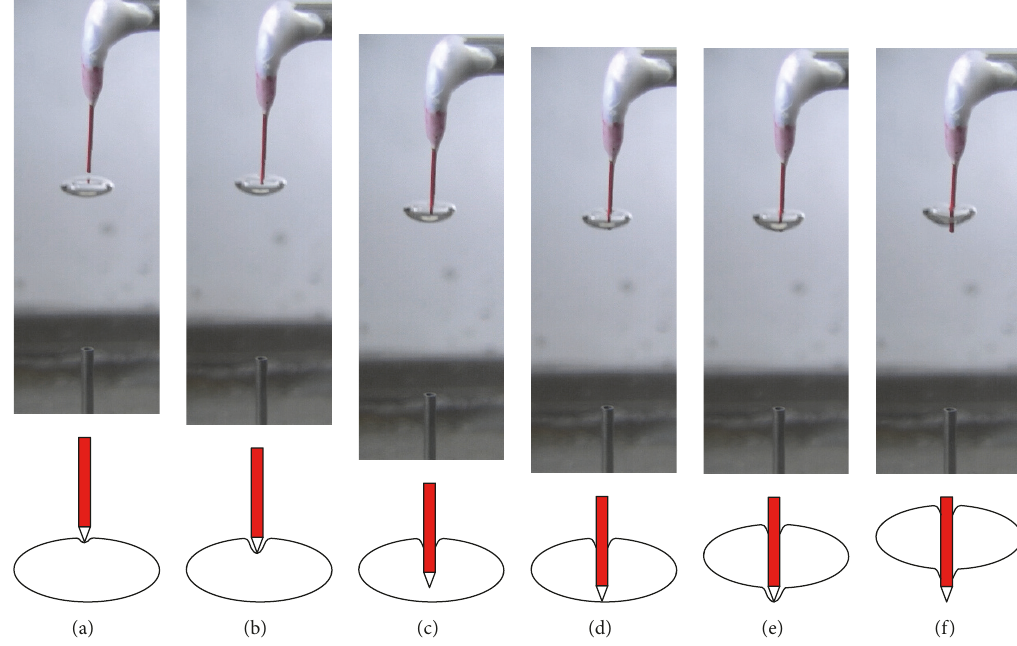
Figure 13: Bubble deformation when passing over the probe (0.1mm inner diameter